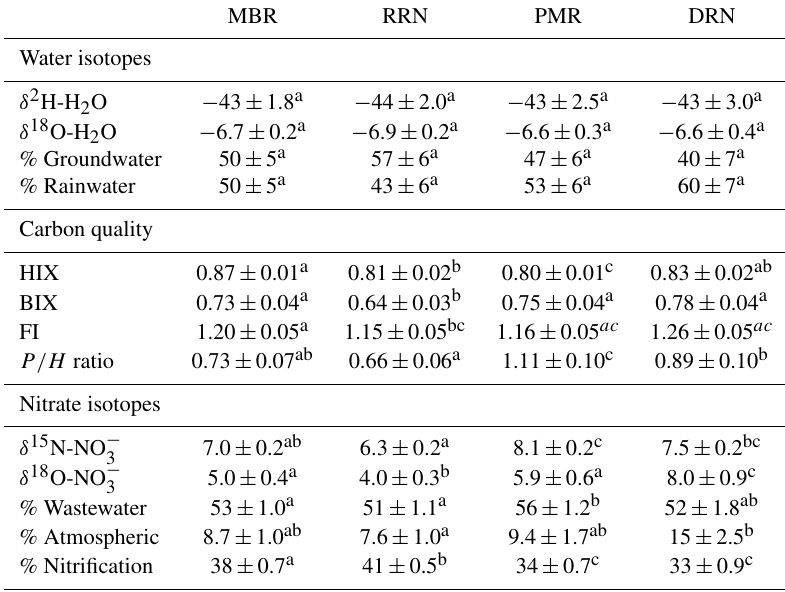
Table 2. Comparisons of water, carbon, and nitrate sources (mean ± SE) among the four urban watersheds.